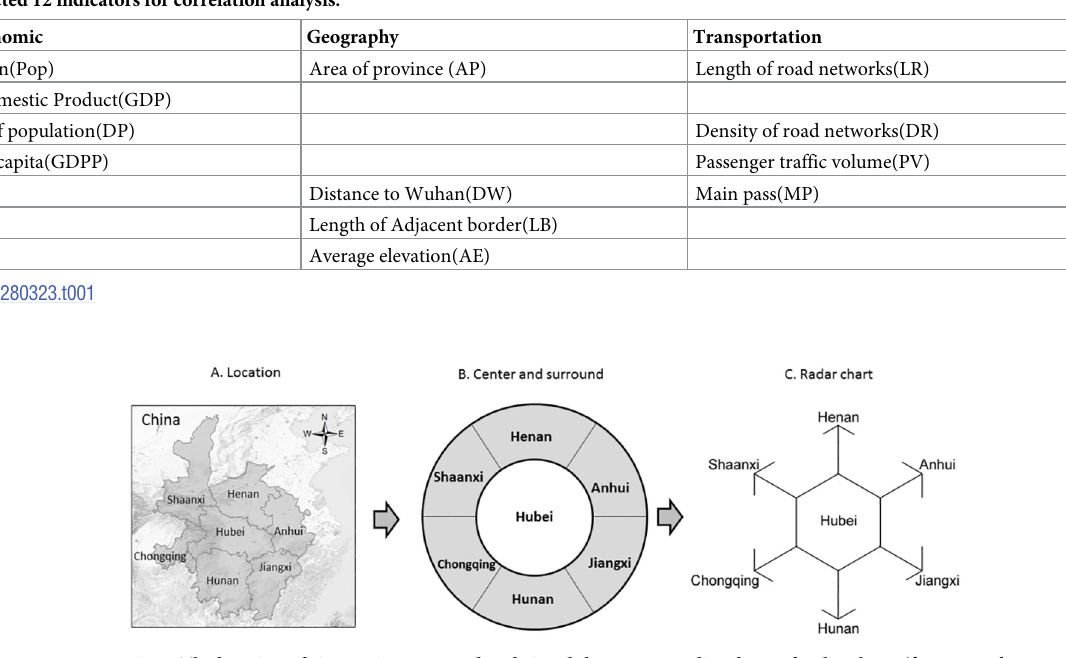
Fig 2. The location of six provinces around Hubei and the corresponding form of radar chart. (figure was drawn by author, A is based on USGS basic information for illustrative purposes only, USGS National Map Viewer (public domain):